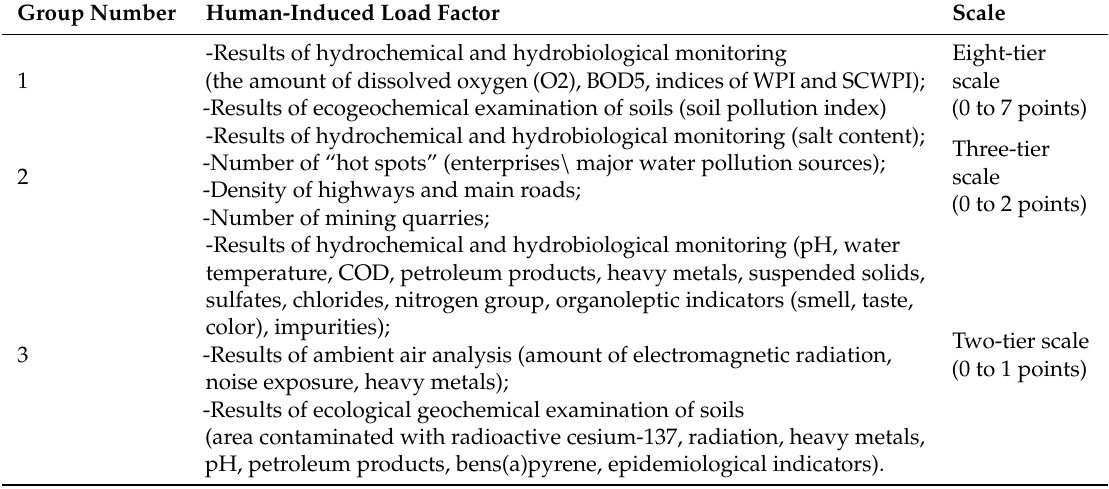
Table 1. The scale of conversion of the absolute human-induced load factors values to the relative ones. Group